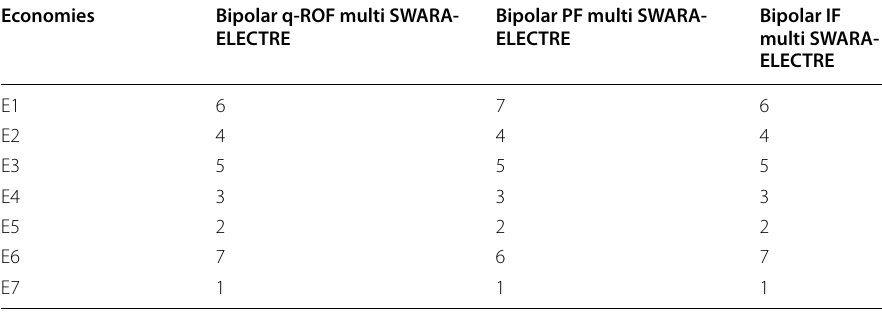
Table 26 Comparative overall ranking results for the